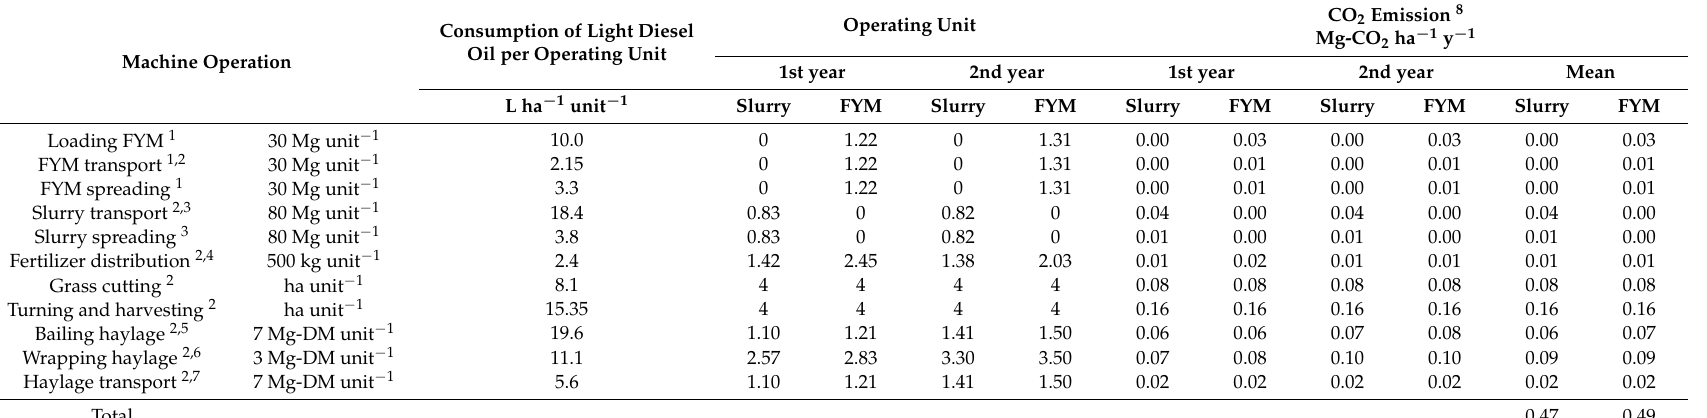
Table 7. Emission of CO 2 related to fuel consumption for grassland management and